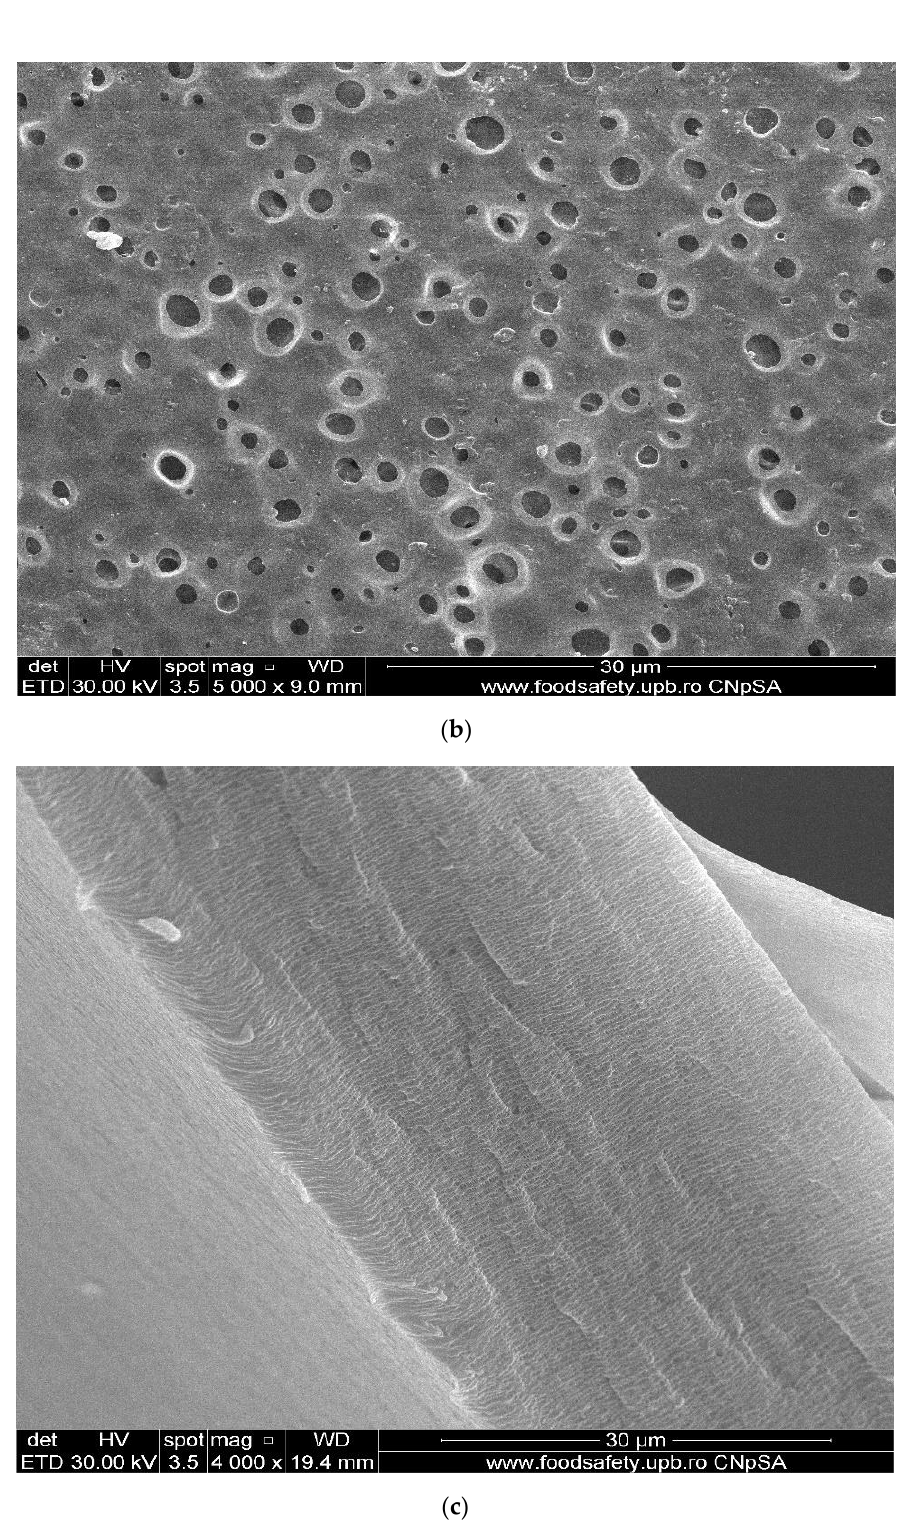
Figure 7. The bottom surface of the cellulose acetate ( a ) and the polysulfone ( b ) membranes, and cross section ( c ) of the polypropylene membranes .